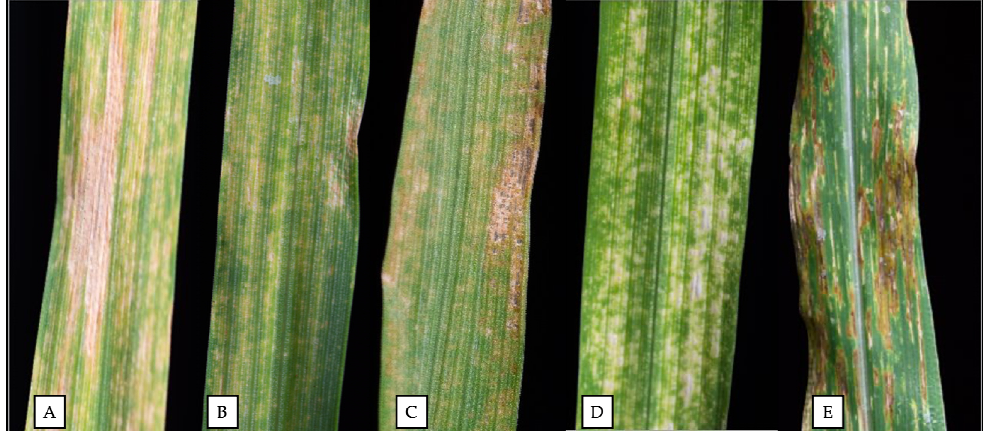
Figure 2. Leaves of cultivated plants showing symptoms of bacterial leaf streak (BLS) 15 days after inoculation (DAI) with the RL1 strain of Xanthomonas vasicola pv. vasculorum ( Xvv ): oat cvs. IPR Afrodite ( A ) and IPR Esmeralda ( B ) with yellowed spots on leaves progressing to chlorosis; ( C ) black oat cv. IPR 161 with yellowed spots on leaves progressing to chlorosis; ( D ) barley cv. BRS Cauê with straw-yellow spots along the veins; and ( E ) maize cv. IPR 164 with streaks and wavy margins on leaves.